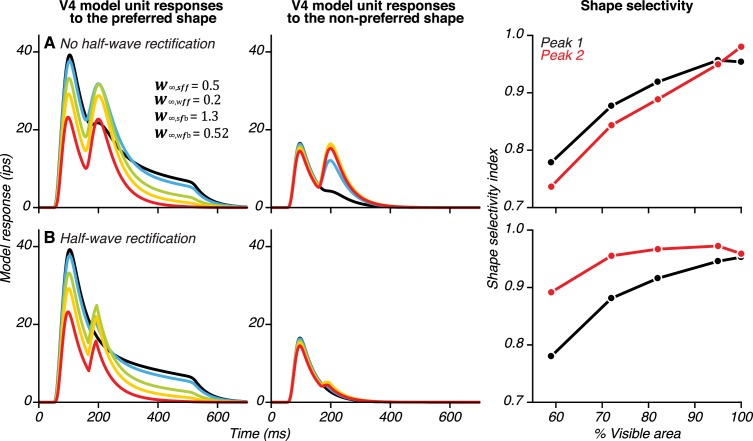
Demonstrating the necessity of half-wave rectification in the model.(A) When we excluded the thresholding and half-wave rectification on the feedback from vlPFC to V4 (see Equation 7, Materials and methods), our simulations produced a large second peak in V4 unit responses both to preferred (left) and to non-preferred stimuli (middle). Thus, without rectification, the model fails to reproduce the enhanced shape selectivity for occluded stimuli during the second peak (right). (B) When thresholding and half-wave rectification are included, a large second peak is observed only in V4 unit responses to the preferred shape (left), and shape selectivity for the occluded stimuli is enhanced at the time of the second peak (right). To compute shape selectivity, we first generated Poisson spikes on 1000 trials, within a 30 ms window centered on the first and the second peaks for responses to both the preferred and non-preferred shapes. We then constructed spike-count distributions and used the area under the ROC curve to compute shape selectivity, as was done for the neuronal data (see Materials and methods).